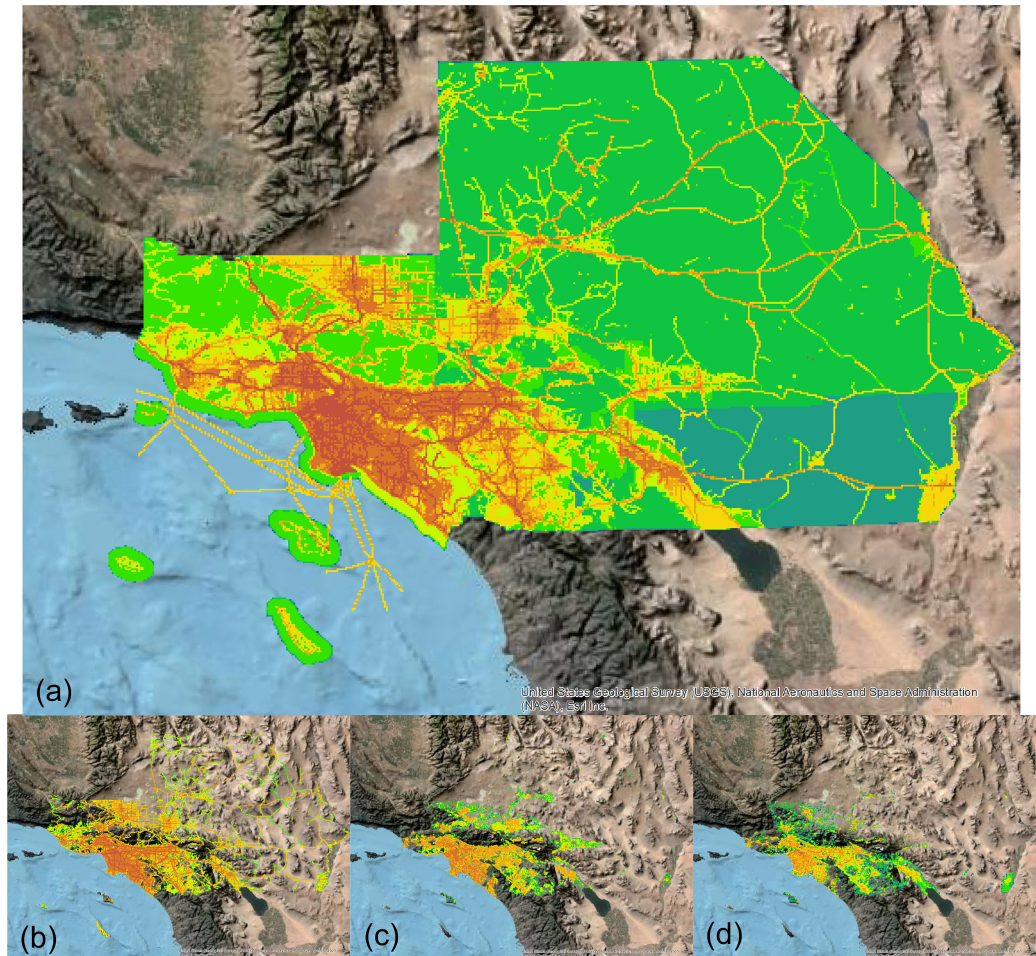
Figure 11. Hestia-LA v2.5 FFCO 2 emissions for the year 2011 represented on a 1km × 1km grid: (a) total FFCO 2 emissions, (b) on-road FFCO 2 emissions, (c) residential FFCO 2 emissions, and (d) commercial FFCO 2 emissions. Units: natural logarithm of kgCyr − 1 .